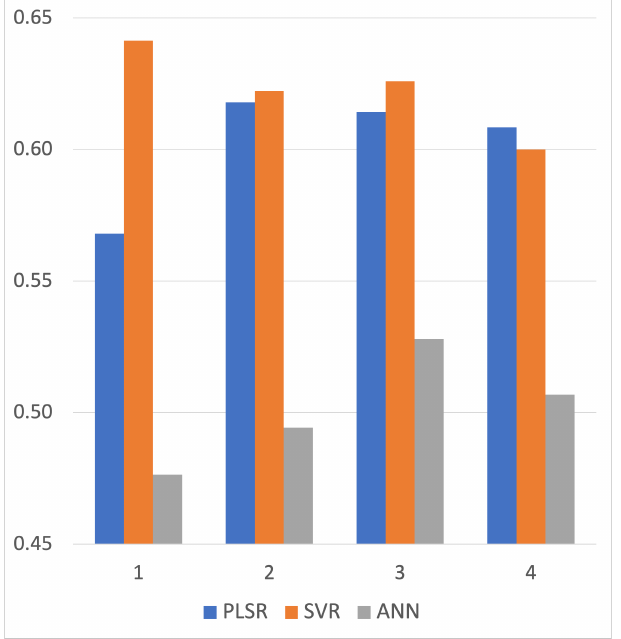
Figure 4. The mean values of R 2 on 20 repeated 6-fold cross-validations using a different number of feature groups for Cu